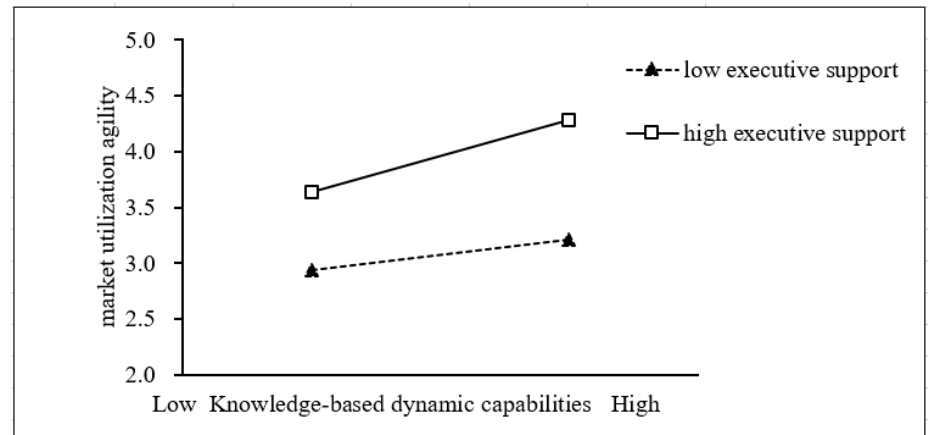
Figure 3. Knowledge-based dynamic capabilities and executive support interact to influence market utilization agility.